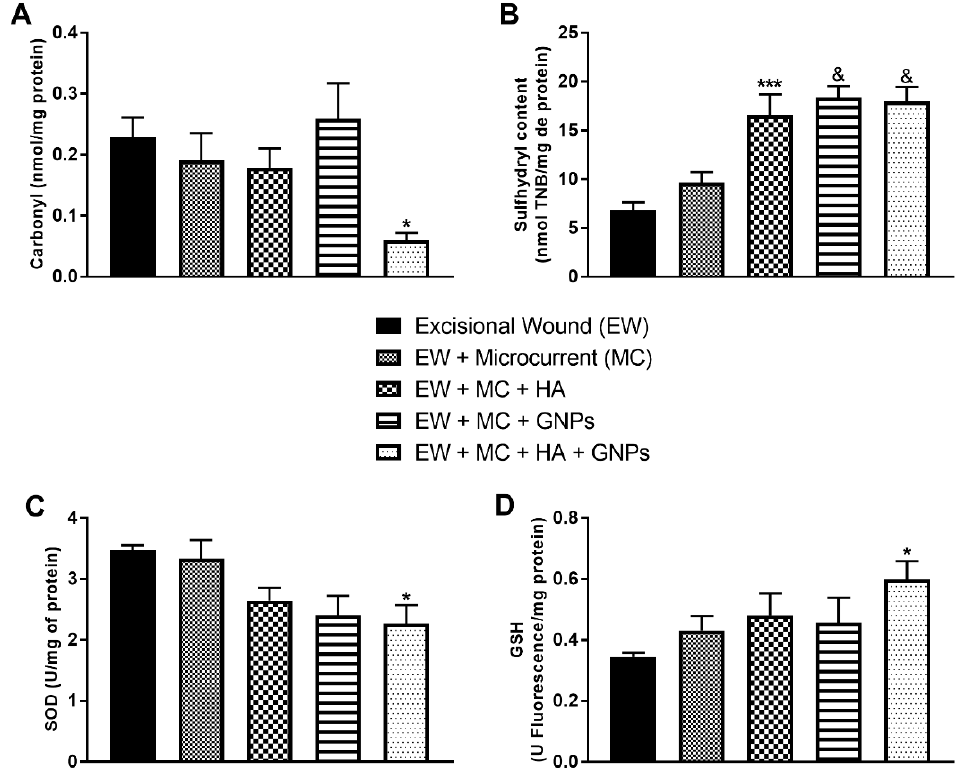
Figure 8. Effects of treatment with MIC, GNPs, and hyaluronic acid on the levels of oxidative damage markers and antioxidants: ( A ) carbonyl; ( B ) sulfhydryl; ( C ) SOD; ( D ) GSH. The data are presented in mean ± EPM, in which: * p < 0.05 vs. Excisional wound group (EW); *** p < 0.001 vs. Excisional wound group (EW); & p < 0.0001 vs Excisional wound group (EW); (one-way ANOVA followed by Tukey’s post hoc test).